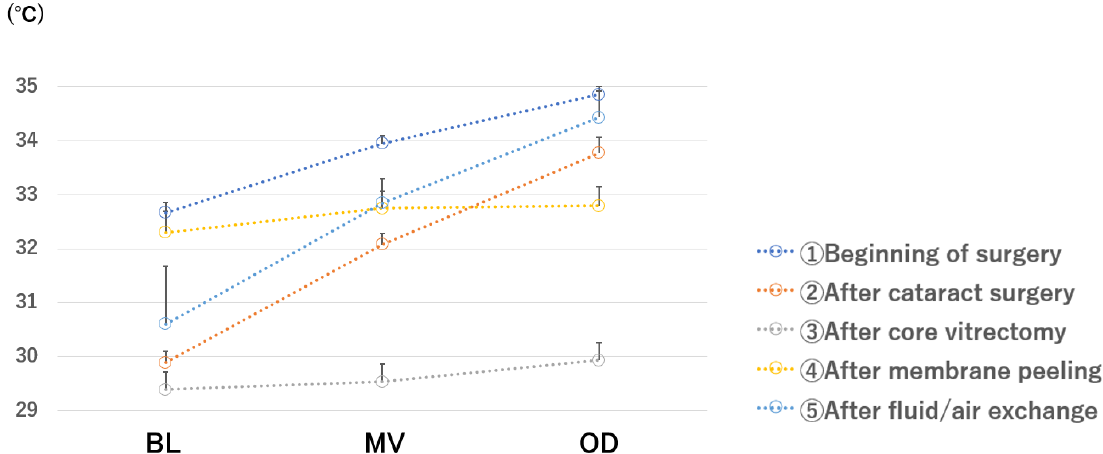
Figure 2. Local temperatures at several intraocular sites. 1 and 2: A temperature gradient was present prior to the surgery, and it became flatter after cataract surgery. 3: After core vitrectomy, the gradient is not present, and the temperature gradient is flattened. 4: After membrane peeling, a temperature gradient is not present. 5: After fluid/air exchange, the temperature is higher at the posterior site and lower at the anterior site, and the temperature gradient is present. Eighteen eyes that did not undergo cataract surgery were excluded. BL, just behind the intraocular lens; MV, mid-vitreous; OD, just anterior to the optic